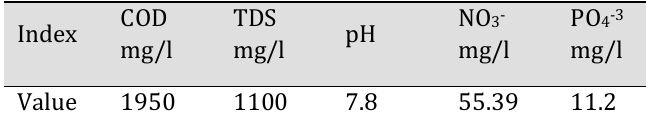
Table 1. Specifications of wastewater used in MBBR system